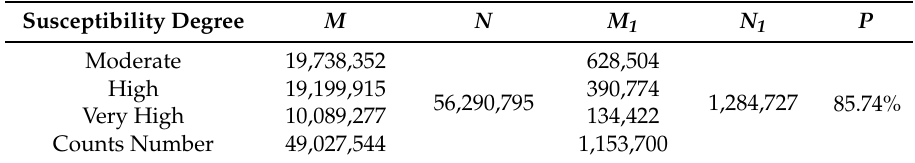
Table 6. The evaluation results accuracy